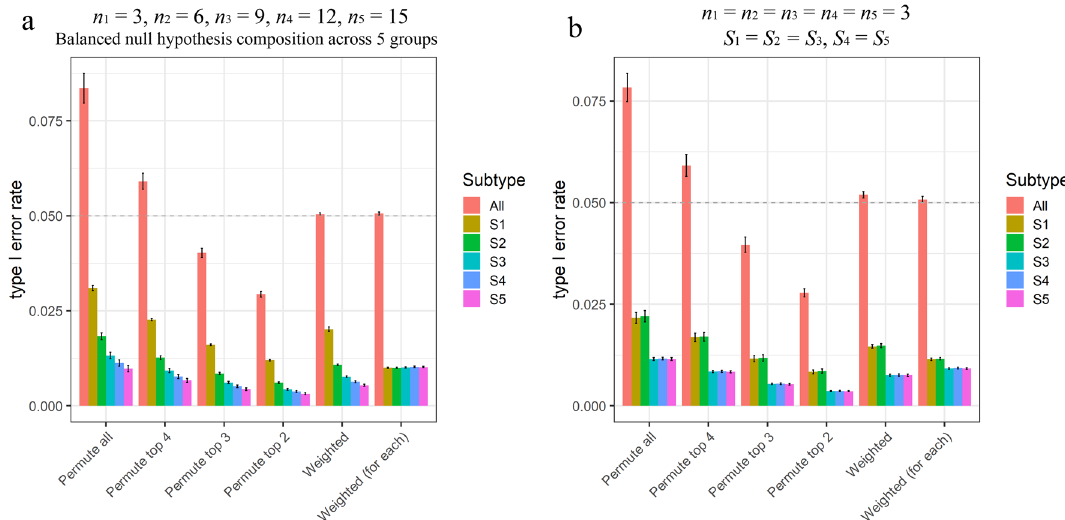
Figure 3. Assessment on Type 1 error rates using simulation data sets involving five subtypes. The results are obtained using the p value cutoff at 0.05 over 150 simulation experiments. 10,000 non-SDEGs are simulated with 30 parameter settings and 5 replicates for each. ( a ) Bar chart of the mean and 95% confidence interval of type I error rates with unbalanced sample sizes. A portion of housekeeping genes take the baseline expression levels across all the five subtypes. The remaining non-SDEGs are adjusted to exhibiting similar upregulations in at least two subtypes. The sample size for subtype S1–S5 is n 1 = 3, n 2 = 6, n 3 = 9, n 4 = 12 and n 5 = 15, respectively. ( b ) Bar chart of the mean and 95% confidence interval of type I error rates with unbalanced compositions of mixture null distribution. Five subtype-specifc profiles are derived from the real gene expression data of two cell lines,where two subtypes are associated with one cell line and other three subtypes are associated with another cell line, making two subtypes closer to each other and other three close to each other. The data are under